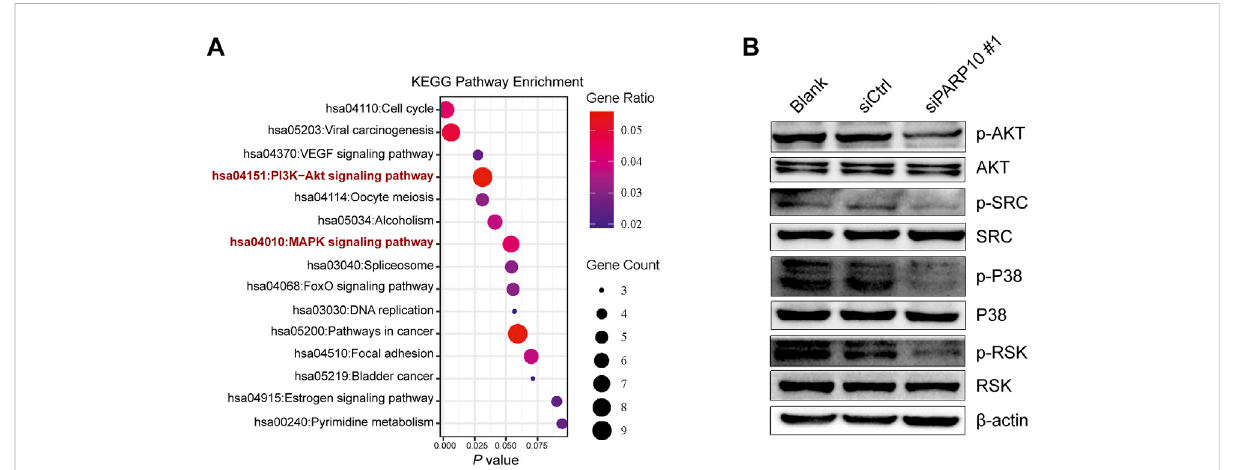
FIGURE 6 Depletion of PARP10 impairs the PI3K-AKT and MAPK signaling pathways. (A) KEGG pathway enrichment analysis of upregulated genes in PARP10 High versus PARP10 Low OSCC in GSE41613. (B) Western blot analysis of proteins that are involved in the PI3K-AKT and MAPK signaling pathways. β -actin was used as an internal